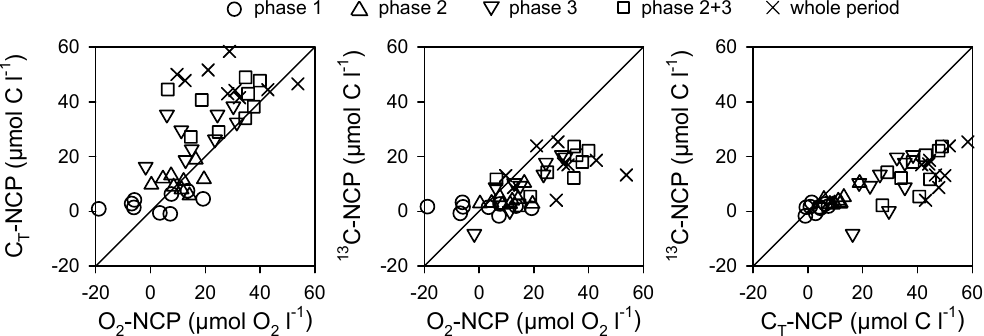
Fig. 4. Comparison of NCP measured with three different methods: temporal changes of total carbon concentration (hereafter, C T -NCP) (Silyakova et al., 2012), net 13 C-POC production (hereafter, 13 C-NCP) (de Kluijver et al., 2012), and net oxygen production in incubation bottles (hereafter, O 2 -NCP) (this study). The data were cumulated for each period: phase 1 ( t 8 to t 13; circle), phase 2 ( t 14 to t 21; upward triangle), phase 3 ( t 22 to t 27; downward triangle), phase 2 + 3 ( t 14 to t 22; square), and the whole period ( t 8 to t 27; cross). When NCP was not measured every day, the data were linearly interpolated before cumulation. See also Table 3. The solid lines indicate the 1 : 1 relationship.